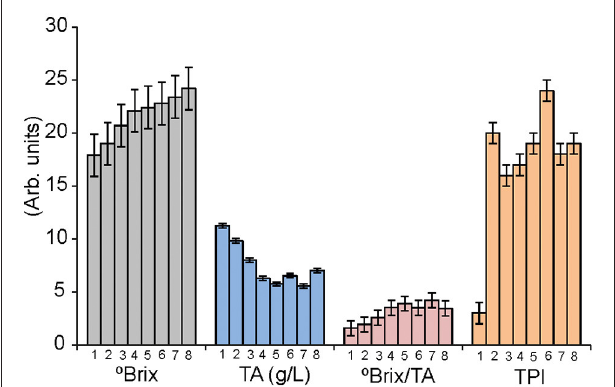
FIGURE 2 | Variation of the ◦ Brix (g sugar/ 100g solution), TA (g/L), Brix/TA and TPI for juices obtained from the variety Tempranillo harvested weekly form véraison to over-ripening.